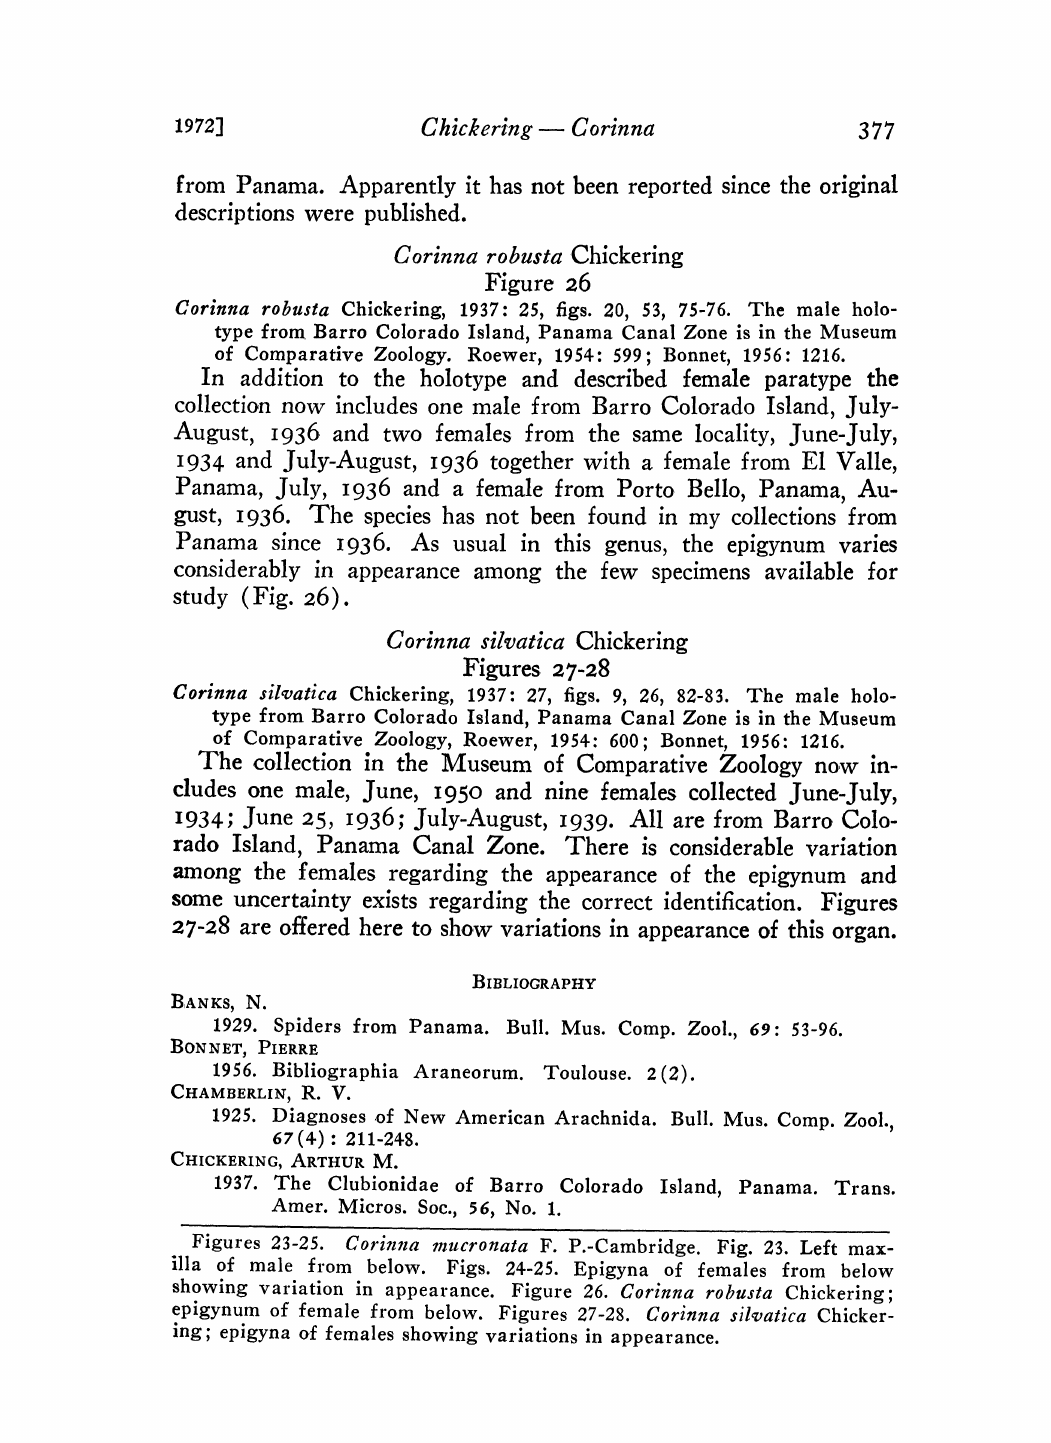
showing variation in appearance. Figure 26. Corinna robusta Chickering; epigynum of female from below. Figures 27-28. Corinna silvatica Chicker- ing; epigyna of females showing variations in